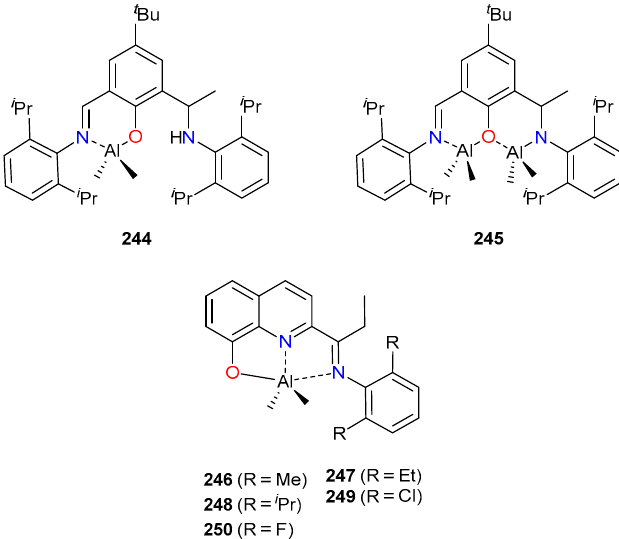
Figure 40. Al complexes of tridentate Schiff-base ligands active in the ROP of ε -CL